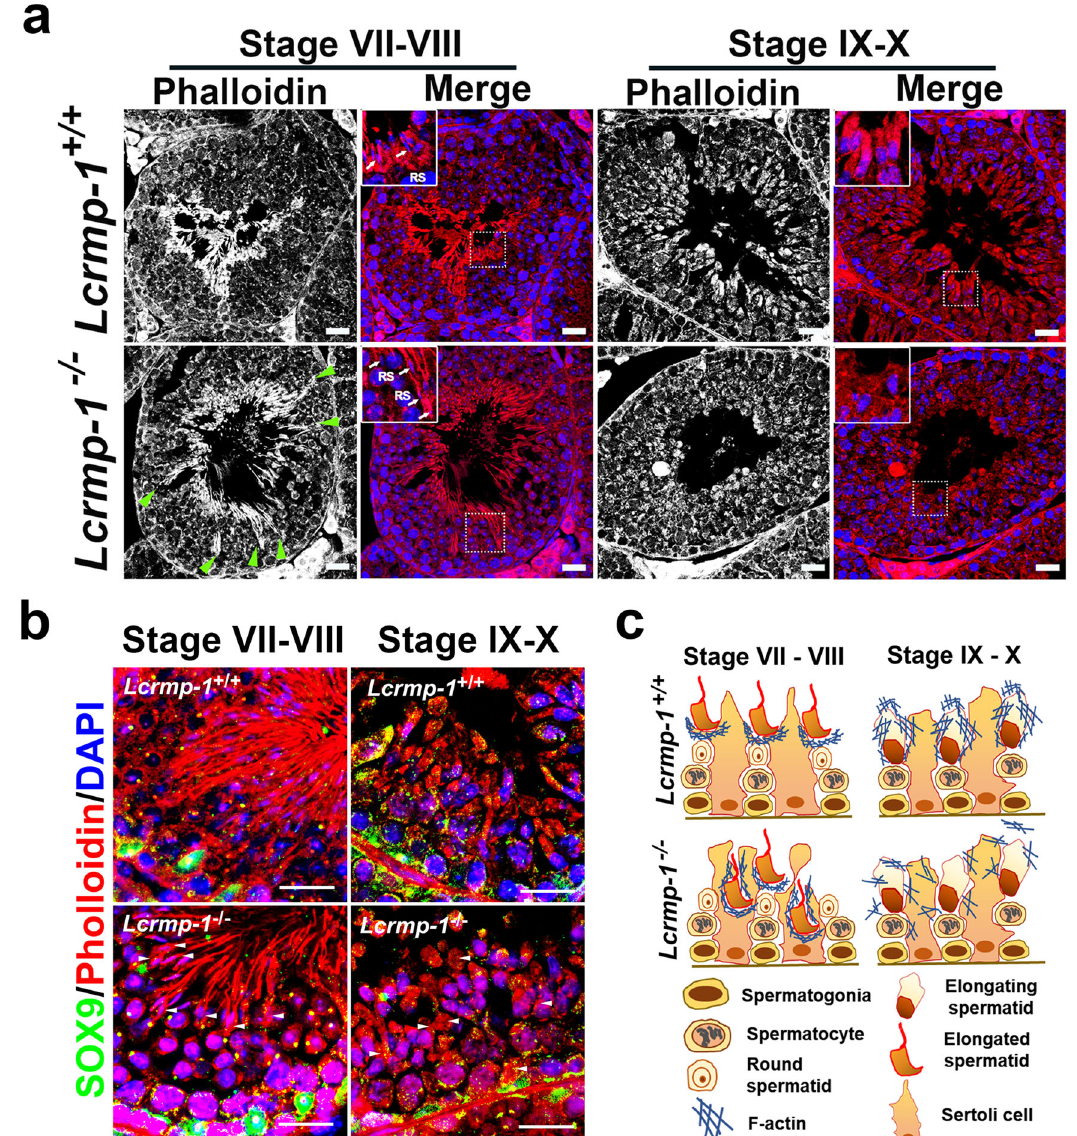
Fig. 6 Disorganized F-actin in Lcrmp-1 − / − mice. a Testis sections were stained using DAPI and phalloidin and subjected to confocal microscope analysis. Green arrowheads indicate retained spermatids near the basal compartment, while the white arrows in the white frames showing magni fi ed sections indicate mature elongated spermatids at stages VII – VIII. In stages XI – X, the white frames show magni fi ed images of the elongating spermatids near the lumen of the seminiferous tubules. The phalloidin results were shown as grayscale images. Scale bars, 20 μ m. b Immuno fl uorescence staining of SOX9 (Sertoli cell), phalloidin (F-actin), and DAPI in stages VII – VIII and IX – X of Lcrmp-1 + / + and Lcrmp-1 − / − mice seminiferous tubules followed by confocal microscope analysis. Arrowheads in stages VII – VIII indicate F-actin wrapping around mature spermatids, and arrowheads in IX – X show disorganized F-actin in elongating spermatids. Scale bars, 20 μ m. c Illustration of disorganized F-actin in Lcrmp-1 − / − mice in comparison to F-actin in wild-type mice. The fi lamentous F-actin retains mature spermatids near the basal compartment of the seminiferous epithelium and surrounds the tails and heads of spermatids during separation from the Sertoli cells in stages VII – VIII as shown in ( a ), ( b ). The disorganized F-actin appears near the tails of elongating spermatids in stages IX – X in Lcrmp-1 − / − mice as shown in ( a ), ( b ). been homogenized in a TissueLyser II (QIAGEN, Germany), the lysates were cen- perform a qPCR analysis, using the Applied Biosystems QuantStudio 3 Real-Time trifuged at 14,000rpm for 20min and the supernatant was sonicated. We then loaded PCR System (Thermo Fisher Scienti fi c, USA), under the following conditions: 50°C, 30 μ g (whole-tissue lysate), 13 μ g (fractionated testicular cells), and 200 μ g (CRMP-1 2min; 95°C, 10min; 40 cycles of 95°C for 15s and 60°C for 1min. The messenger and LCRMP-1 expression in testis) protein with 4× sample buffer into each well. The RNA (mRNA) expression level was normalized to the gene expression level of samples were electrophoresed on 12% or 10% sodium dodecyl sulfate-polyacrylamide TATA-binding protein (TBP). We performed three technical replicates for each gels and transferred onto polyvinylidene di fl uoride membranes (Millipore, USA). sample and calculated the values using the comparative threshold cycle method These membranes were blocked with 1% nonfat milk or 1% BSA and incubated with (2 − Δ Ct ). The qPCR primers are listed in Supplementary Table 2. primary antibodies overnight at 4°C (anti-CRMP-1, Cat. #sc-365348, Santa Cruz biotechnology, 1:1000, Cat. #PA5-34768, Thermo Fisher Scienti fi c, 1:1500; anti- Protein extraction and Western blotting . Testes and brain tissues were lysed in LCRMP-1, homemade 14 , 1:10,000; anti-GSK3 β , Cat. #9315, Cell Signaling Technol- T-PER Tissue Protein Extraction Reagent (Cat. #78510, Thermo Fisher Scienti fi c, ogy, 1:1000; anti-phosphorylated GSK3 β , Cat. #9336, Cell Signaling Technology, USA) with Phosphatase Inhibitor Cocktail (Cat. #4906837001, Roche, USA) and 1:1000; anti-GFP, Cat. #2956, Cell Signaling Technology, 1:1000; anti-cleaved caspase Protease inhibitor cocktail (Cat. #S8830, Sigma-Aldrich, USA). After the tissues had COMMUNICATIONS BIOLOGY| (2023) 6:389 |https://doi.org/10.1038/s42003-023-04778-2|www.nature.com/commsbio